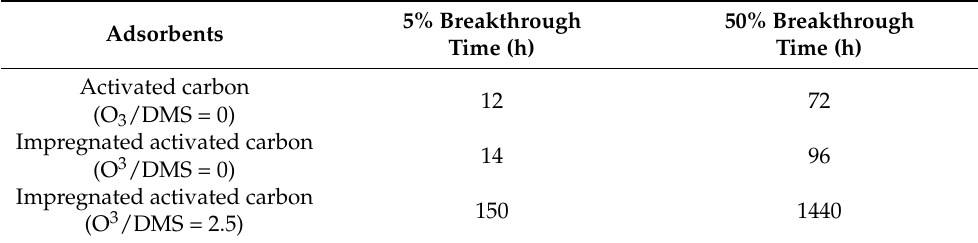
Figure 10. The time variation of outlet DMS concentration. Table 3. The 5% and 50% breakthrough times of dynamic adsorption experiments.